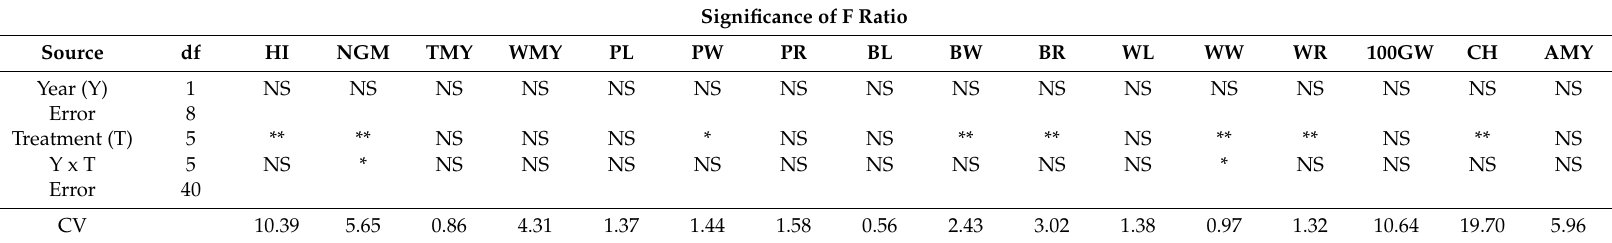
Table 5. Analysis of variance (one factor randomized complete block design combined over years) of the agronomic, qualitative, and physico-chemical traits as influenced by the compost